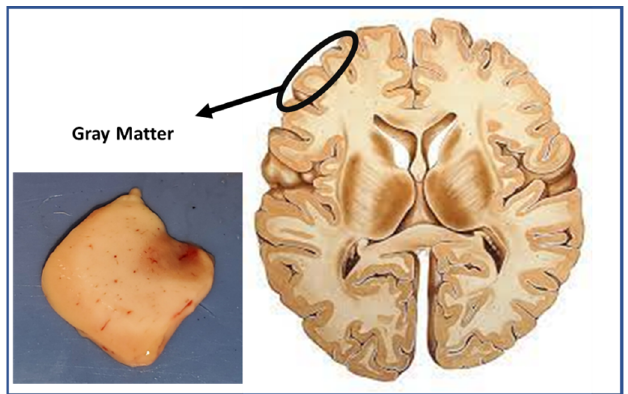
Figure 3. The gray matter is the dark region of the outer surface of the cerebral cortex of the human brain. The inset shows a photograph of human gray matter tissue using a conventional camera.